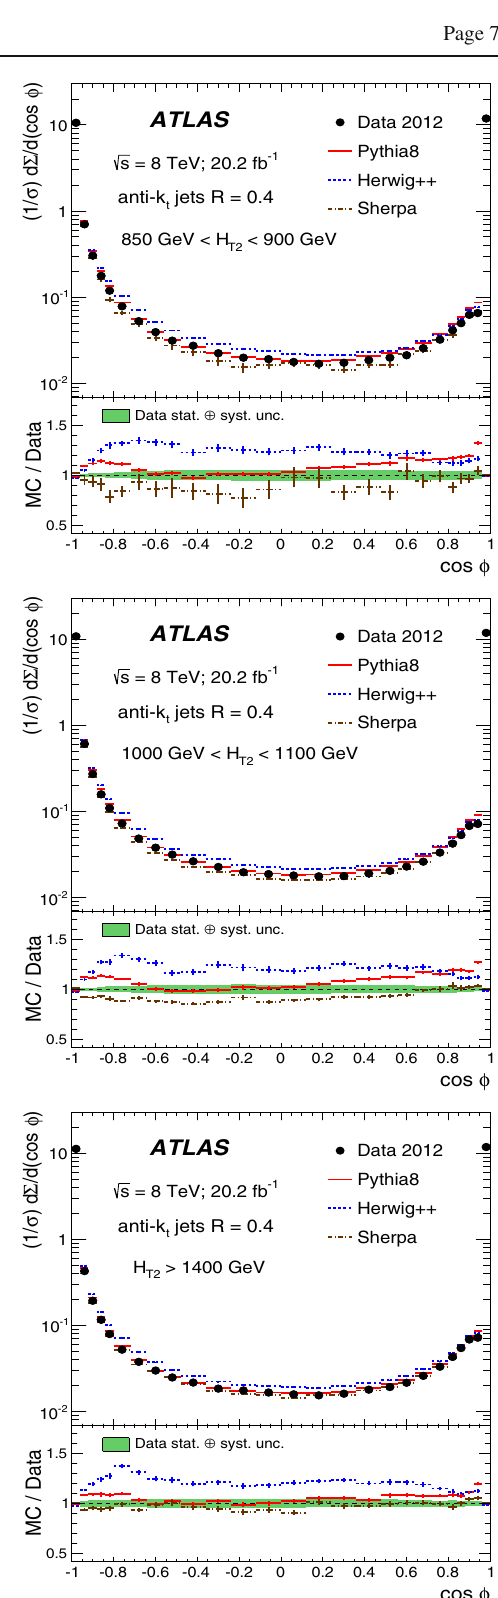
ing statistical and other experimental sources is also indicated using an error bar for the distributions and a green-shaded band for the